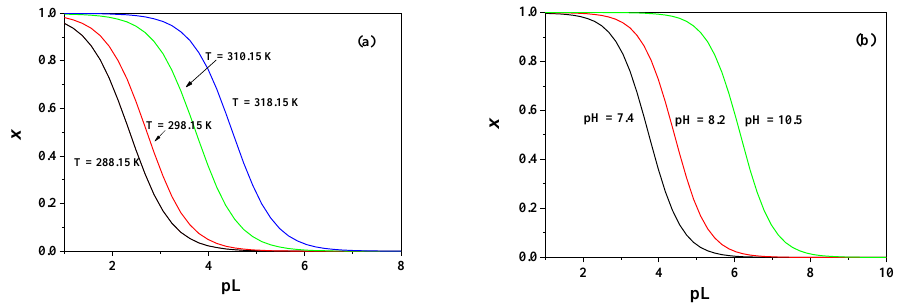
Figure 7. Sequestering diagram of dopamine towards CH 3 Hg + in NaCl aqueous solution. ( a ) I = 0.15 mol dm −3 , pH = 7.4 at different temperatures; ( b ) I = 0.15 mol dm −3 , T = 310.15 K and different pH values. pL 0 . 5 values: ( a ) 2.36 ( T = 288.15 K) < 2.63 ( T = 298.15 K) < 3.74 ( T = 310.15 K) < 4.50 ( T = 318.15 K). ( b ) 3.74 (pH = 7.4) < 4.41 (pH = 8.2) < 6.15 (pH = 10.5).